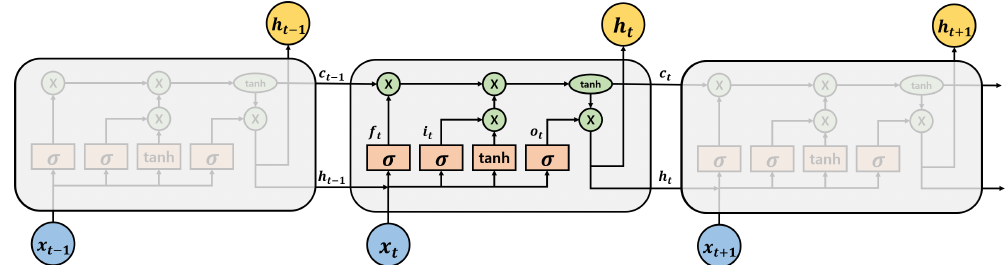
Figure 4. The structure of the Long-Short Term Memory (LSTM) cell. It contains input gate (cid:126) i t , output gate, (cid:126) o t , forget gate (cid:126) f t , hidden state (cid:126) h t and cell state (cid:126) c t . The σ symbol means sigmoid function and tanh means hyperbolic tangent function.